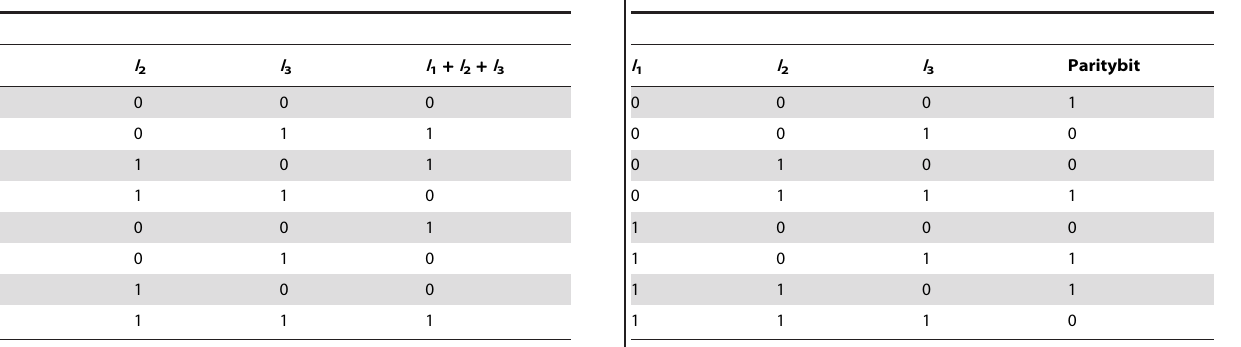
Table 4. Truth table for a Three-bit adder. Table 5. Truth table for a 3-Parity bit